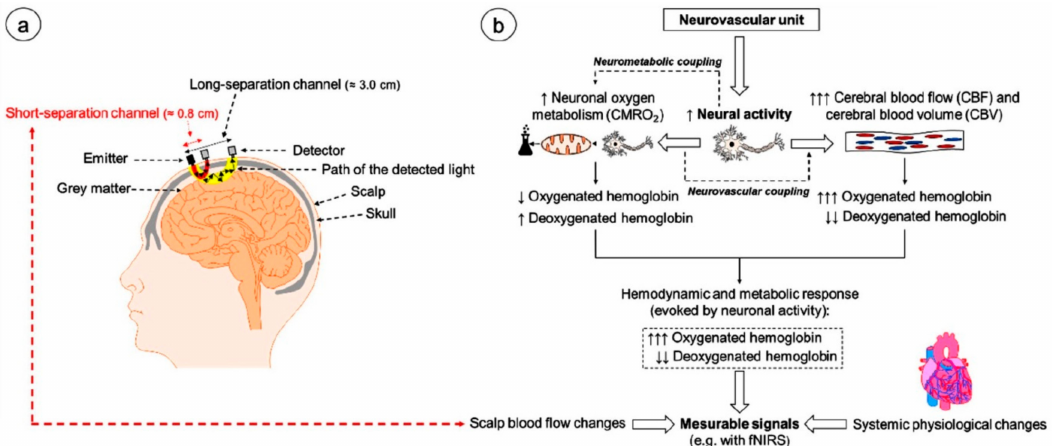
Figure14. ( a )Schematicillustrationoftheneurovascularunitandthechangesincerebralhemodynamics and oxygenation induced by neural activity. ( b ) Exemplary illustration of a possible NIRS montage on the human head and the assumed banana-shaped course of detected light of “short-separation channels” and of “long-separation channels”. fNIRS, functional near-infrared spectroscopy; CMRO2, cerebral metabolic rate of oxygen; increase; decrease. Reproduced in compliance with CC BY 4.0 license from Ref.